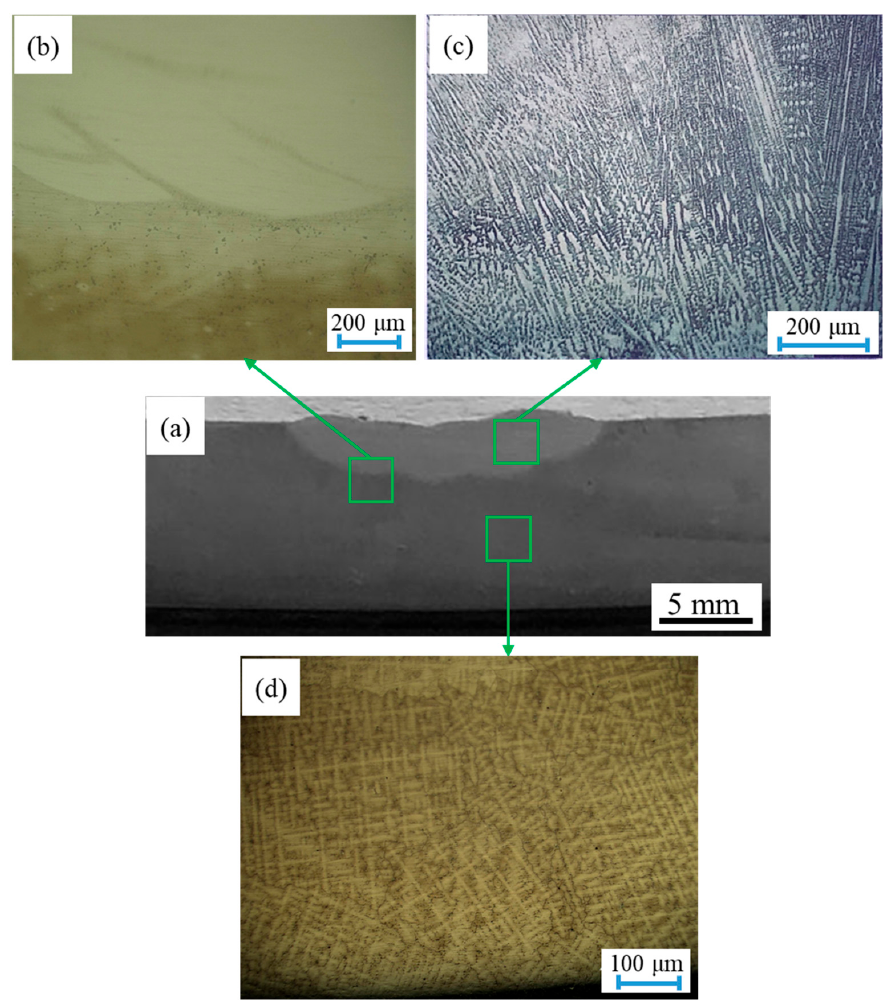
Figure 9. Microstructure of A1 welded specimen; ( a ) cross-section view, ( b ) HAZ, ( c ) FZ and ( d ) BM.